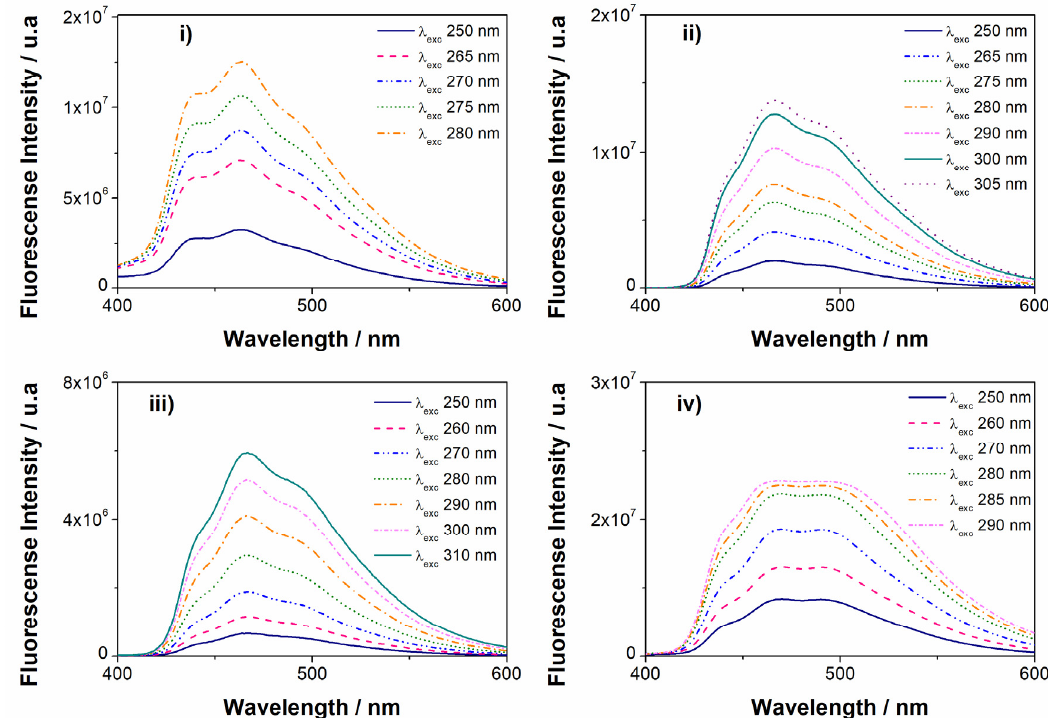
Figure 11. Photoluminescence spectra obtained for A(170)_ 3a OIH matrices: ( i ) A(170)_ 3a @500; ( ii ) A(170)_ 3a @600; ( iii ) A(170)_ 3a @900; ( iv ) A(170)_ 3a @1000.